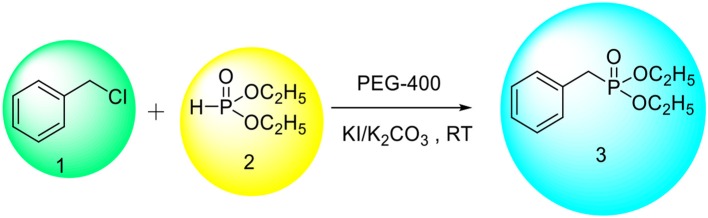
Synthesis of benzyl phoshponates over PEG-400/KI.K2CO3 system.